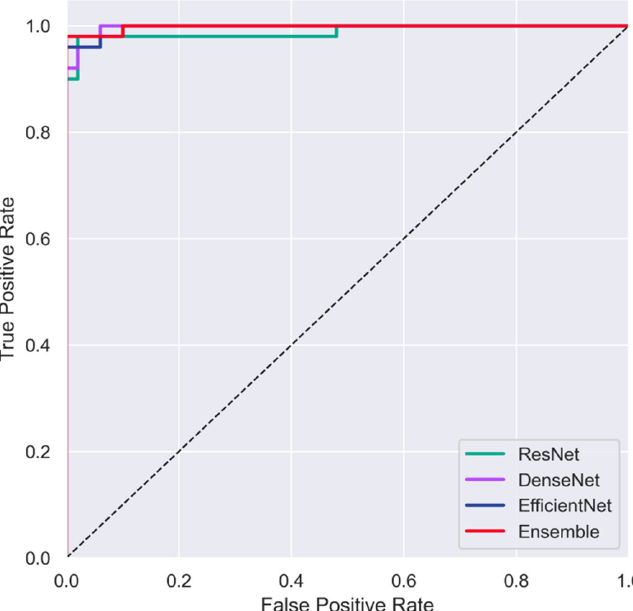
Figure 3. Diagnostic performances of the ResNet ‐ 152 (green), DenseNet ‐ 201 (purple), EfficientNet ‐ B7 (blue), and ensemble models (red). The diagnostic performances of the CNN model with ResNet ‐ 152, DenseNet ‐ 201, and EfficientNet ‐ B7 and the ensemble model were 0.989 (95% CI, 0.968–1.000), 0.997 (95% CI, 0.986–1.000), 0.997 (95% CI, 0.986–1.000), and 0.998 (95% CI, 0.989–1.000), respectively.